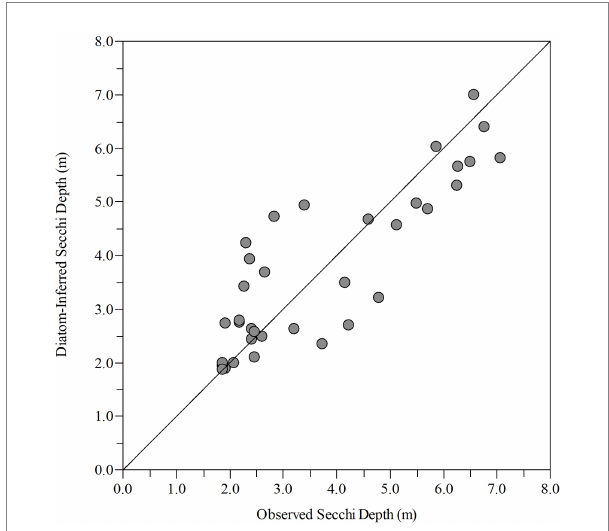
FIGURE 6 Observed vs. diatom-inferred Secchi depth from the paleo model